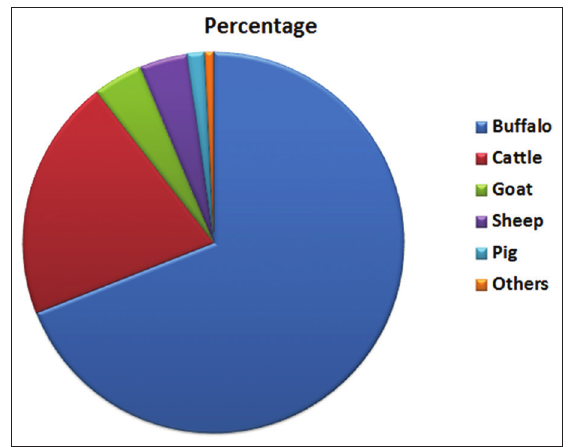
Figure-2: Distribution of livestock in Haryana. Adapted from 19 th livestock census 2012, chapter 14, Haryana.